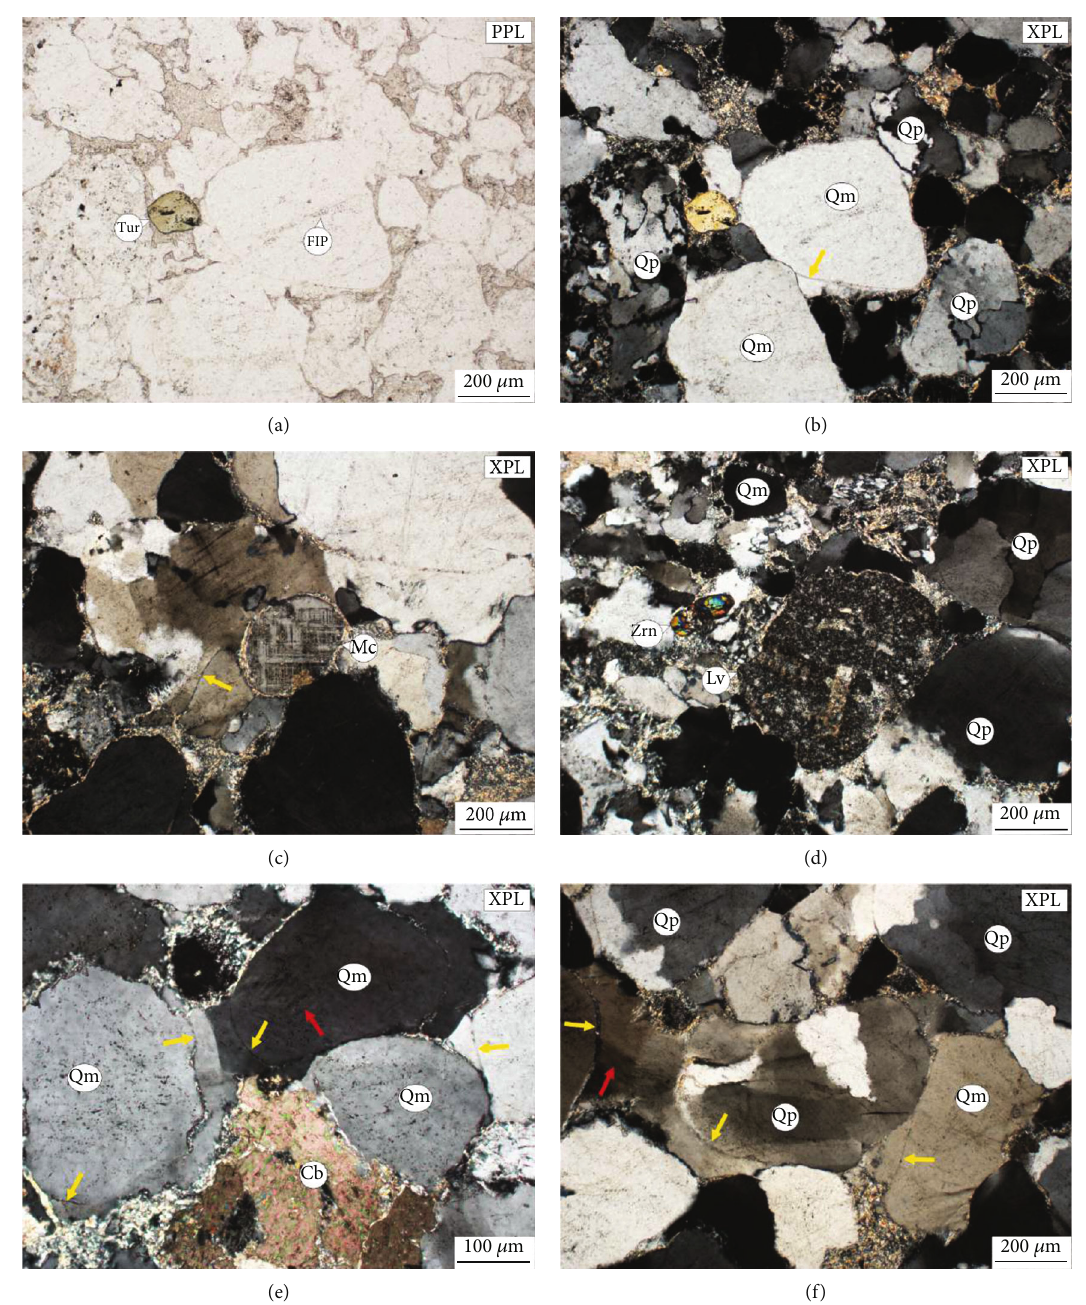
Figure 9: Thin-section photomicrographs of Lower Triassic sandstones showing a mature composition of quartz arenite (well Móra – 1 core #17). (a – d) Rounded framework grains and accessory minerals. Notice the line of inclusions marked by yellow arrows showing the original grain boundary. Quartz grains and overgrowths are frequently replaced by microcrystalline silica. Sets of parallel microcracks marked by fl uid inclusion plains also occur. (e, f) Overgrowth cement is postdated by silica and carbonate replacement. The original grain boundaries are visible as lines of tiny inclusions (yellow arrows). Note: deformation lamellae in quartz (red arrow). Abbreviations: PPL: plane-polarized light; XPL: cross-polarized light; FIP: fl uid inclusion plain; Cb: carbonate; Lv: volcanic lithic fragment; Mc: microcline; Tur: tourmaline; Qm: monocrystalline quartz; Qp: polycrystalline quartz; Zrn: